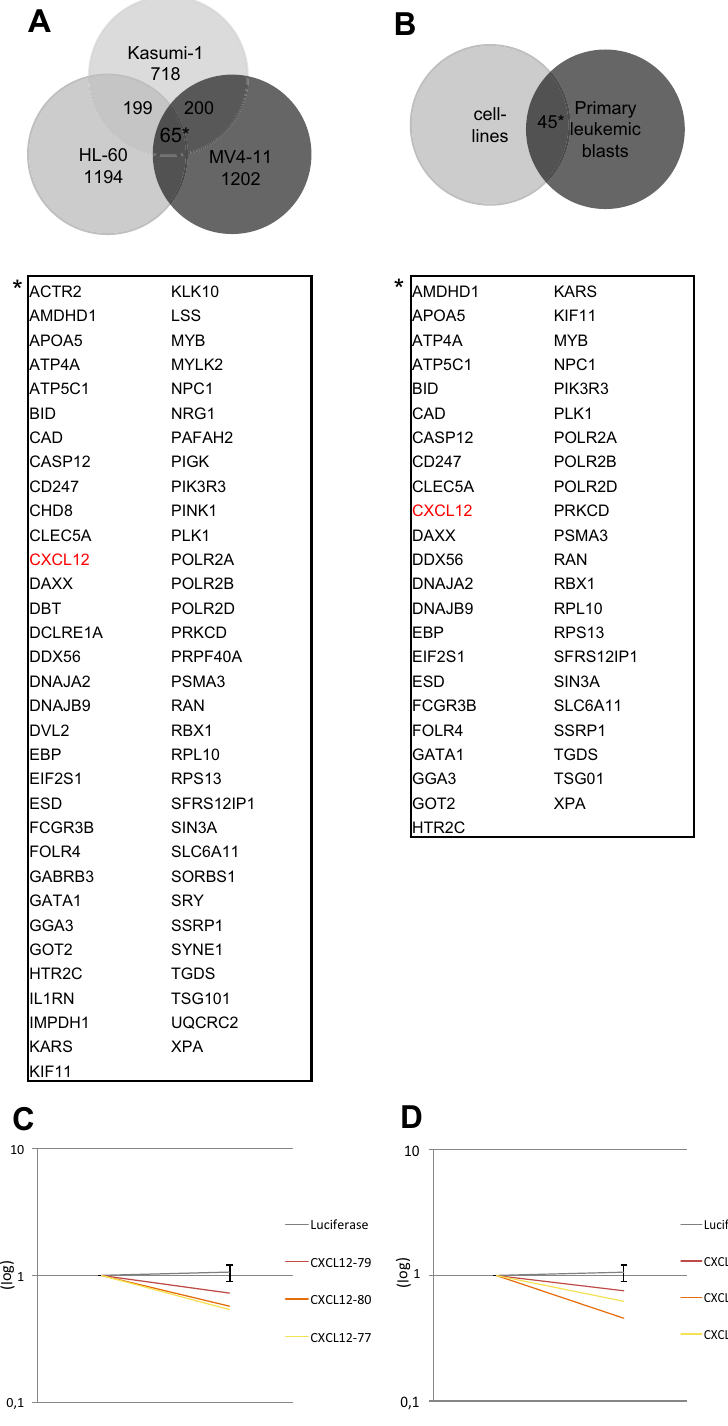
Figure 4. Comparison of results in the cytarabine group and primary cells. ( A ) Venn diagram shows the number of potential therapeutic targets in each tested cell line in the AraC/d05 analysis and visualizes mutually depleted genes (fold change < 0.6) with at least two independent shRNAs targeting the same gene. Among the 65 hits is CXCL12. ( B ) Venn diagram shows mutually depleted genes of cell lines (HL-60, Kasumi-1, MV4-11) and primary leukemic blasts when comparing AarC/d05 ratio. Again, only targets with two independent shRNAs were taken into account. ( C , D ) Plots showing median depletion of different shRNAs targeting CXCL12 in cell lines ( C ) and in primary leukemic blasts ( D